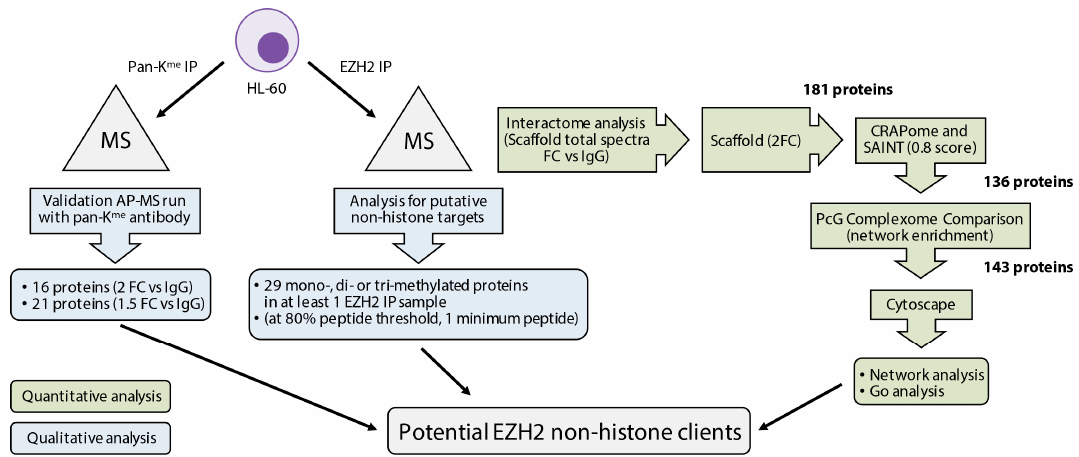
Figure 5. Summary of mass spectrometry (MS) strategy to identify potential non-histone clients in HL-60 cells.